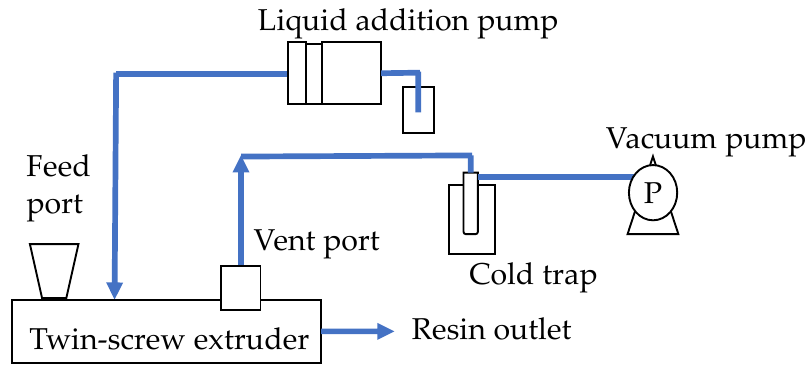
Figure 5. Schematic diagram of the apparatus configuration.